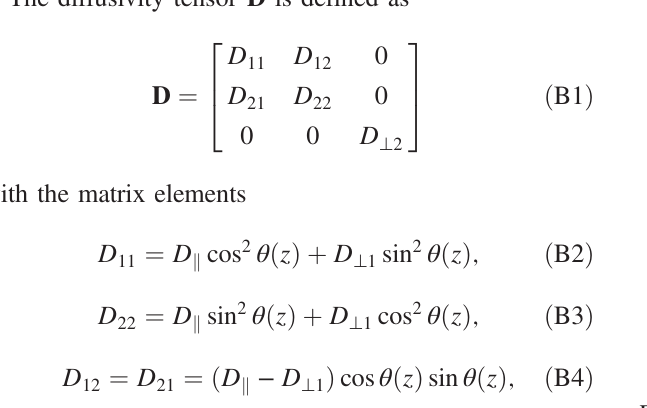
FIG. 13. Characteristic electrical impulse and contraction shapes exhibited by the electrophysiology model described in Sec. II B 1 and Appendix B. In this graph, a 1D representation of the equations is solved using the forward Euler method. In this simulation, D ¼ 1 . 1 cm 2 s − 1 , Re ¼ 0 . 8 , dx ¼ 3 × 10 − 2 cm, and dt ¼ 2 . 0 × 10 − 4 s. Other parameters can be found in Table I. The left vertical axis corresponds to the variables U or v , and the right vertical axis represents the dimensionless magnitude of the active contracting strain T . The horizontal axis is time in the units of a